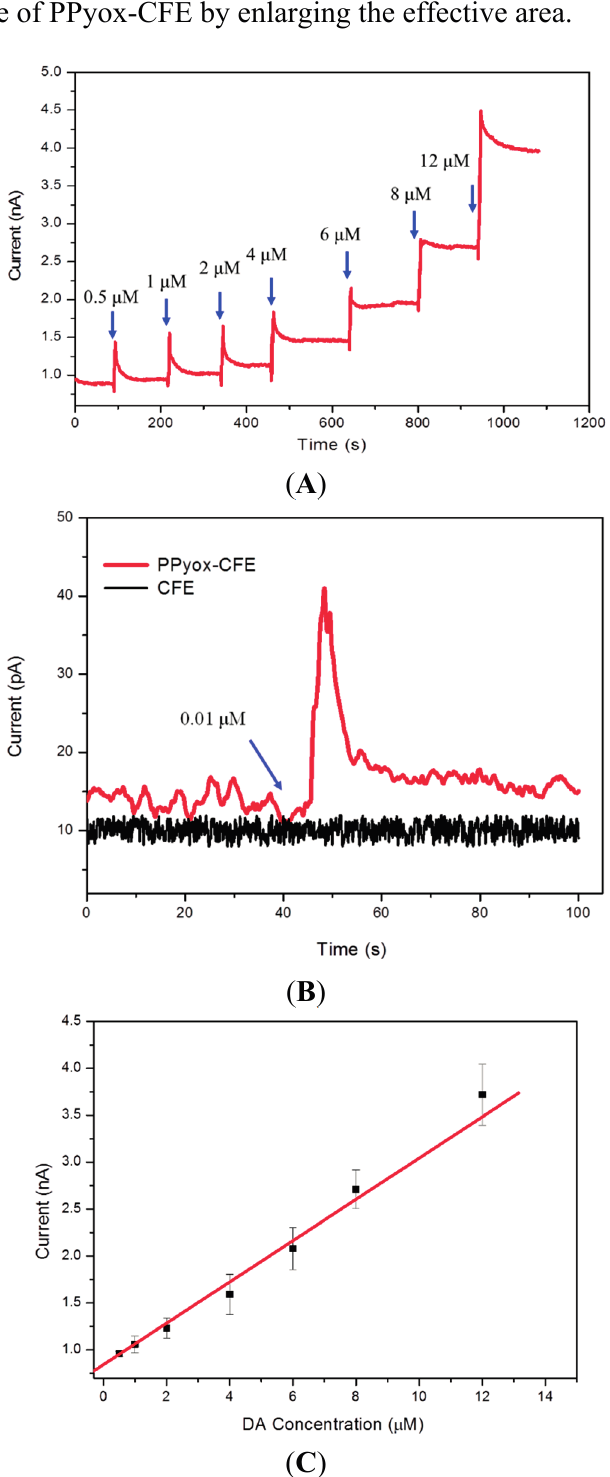
Figure 4. ( A ) Current-time response of the CFE electrodeposited with PPyox film at different concentrations at 149 mV vs. Ag|AgCl; ( B ) Detection limit of DA using PPyox-CFE; ( C ) Plot of current versus concentration of DA in the range of 0.5 µM to 12